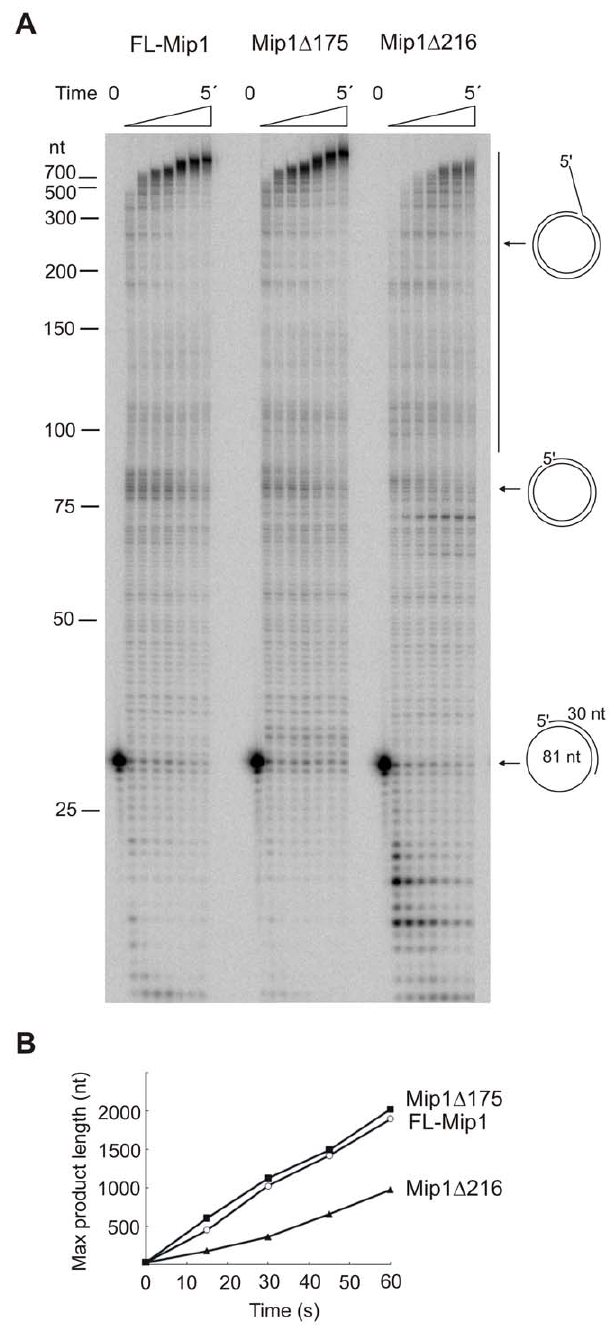
Figure 8. Strand displacement activity of Mip1 and C-terminal deletion mutants. Strand displacement activity was measured on an 81 nt minicircle DNA substrate singly primed with a 30 nt primer. The reaction was performed with 12 nM DNA polymerase, 20 nM minicircle substrate and 100 m M dNTP. The reaction was carried out at 30 u C and stopped after 0 s, 15 s, 30 s, 45 s, 1 min, 2 min, 3 min or 5 min. A. Reaction products were resolved on denaturating 8% urea polyacryl- amide gel. The position of the reaction substrate, product elongated to the full-length minicircle size and the products of strand-displacement reaction are indicated with arrows. B. Maximum product length was plotted against time. FL-Mip1 – empty circle, Mip1 D 175 –filled square, Mip1 D 216 – filled triangle.